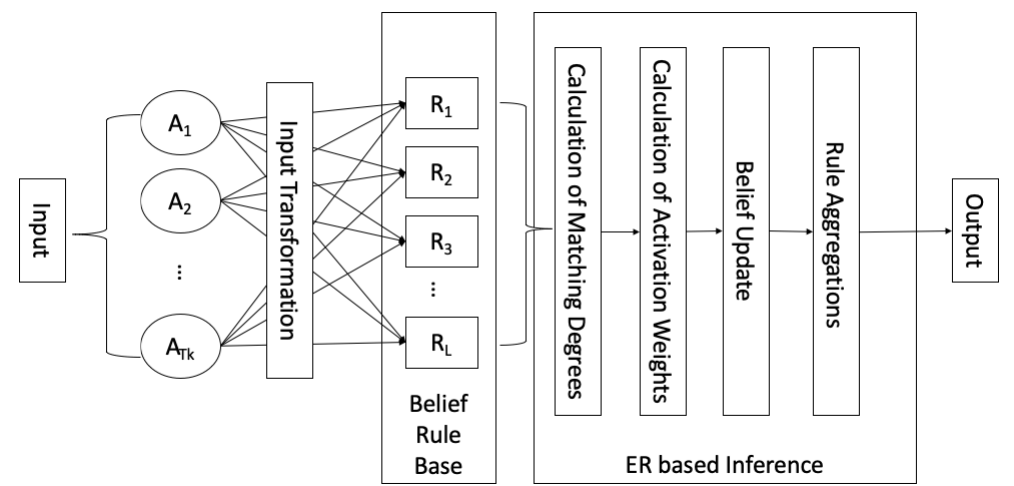
Figure 2. Working process of BRB Expert System (BRBES).